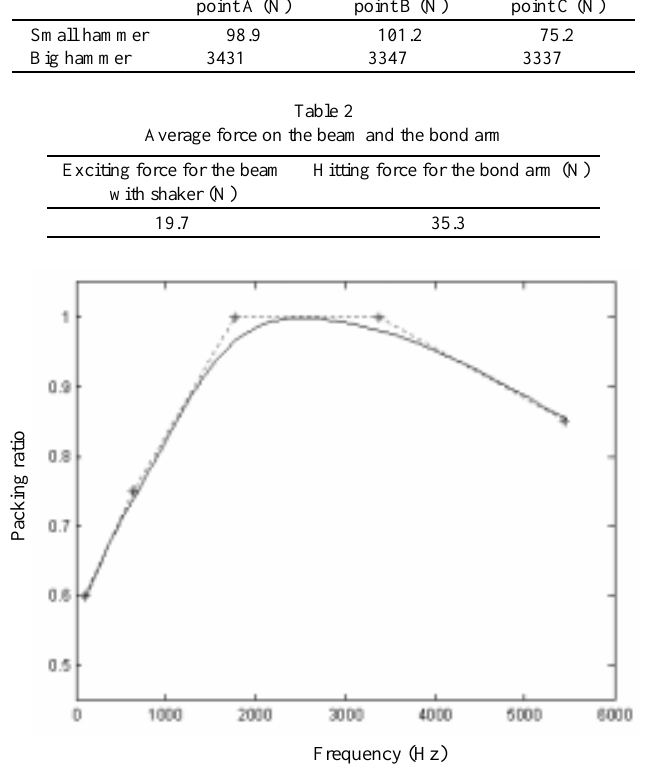
Fig. 9. The relationship between packing ratio and